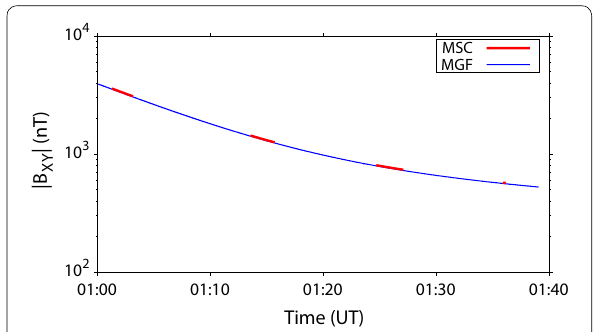
Fig. 14 Comparison of geomagnetic field values in the X – Y plane observed by the MSC and MGF for the period of 01:00–01:40 UT on